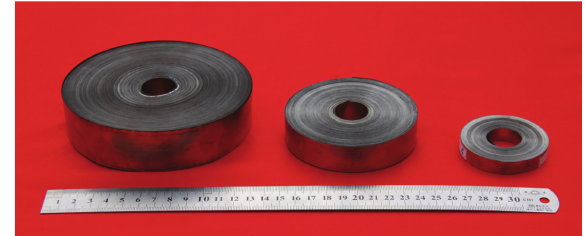
Figure 1: Melt spinning Fe-6.5wt%Si ribbons of 30 𝜇 m in thickness, with width of 30 mm, 20 mm, and 10mm from left to